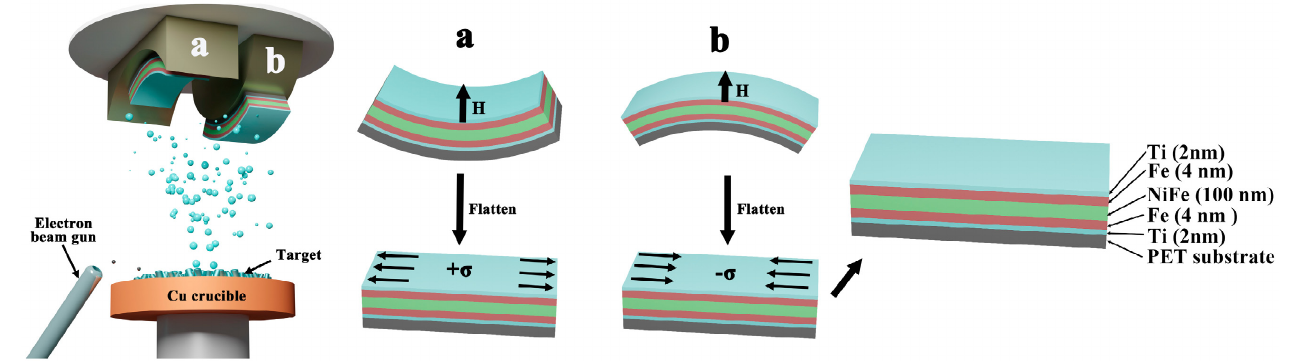
Figure 1. Schematic diagram of electron beam evaporation of flexible TFNFT film: ( a ) concave mold, ( b ) convex mold.